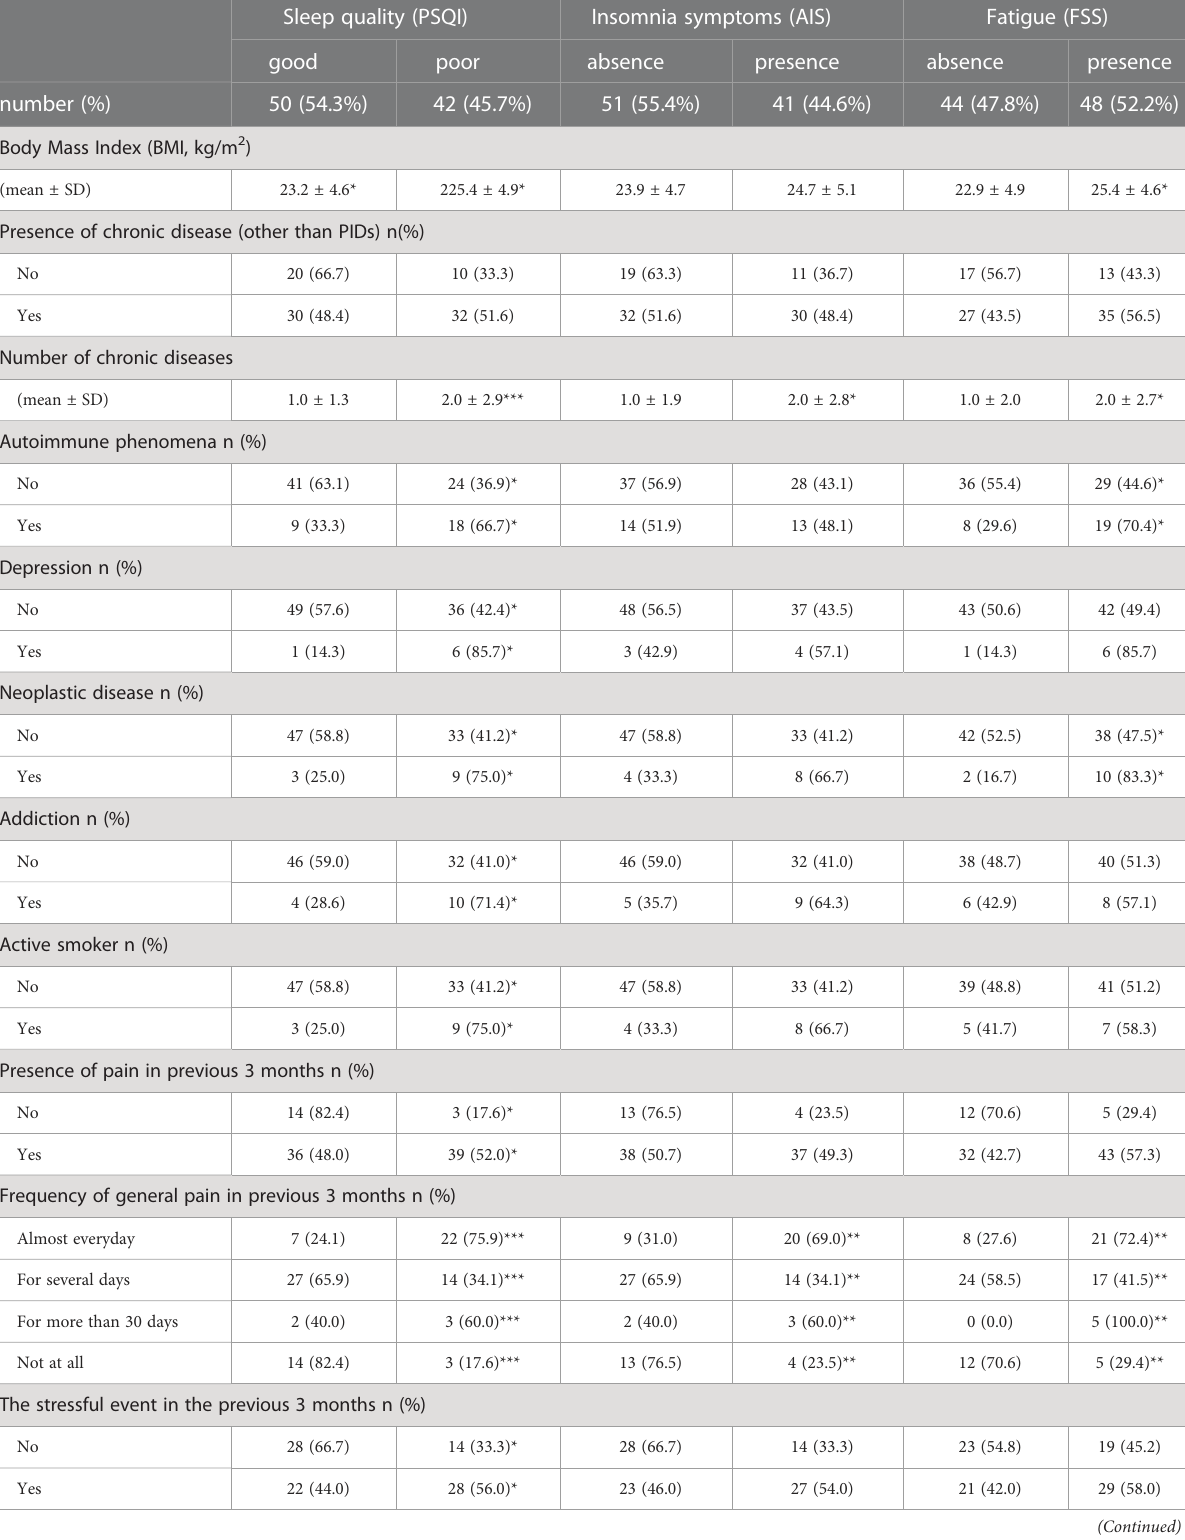
TABLE 4 Comparison of patients with good or poor sleep quality (PSQI), absence or presence of insomnia symptoms, and absence or presence of fatigue symptoms according to clinical data. Sleep quality (PSQI) Insomnia symptoms (AIS) Fatigue (FSS) good poor absence presence absence